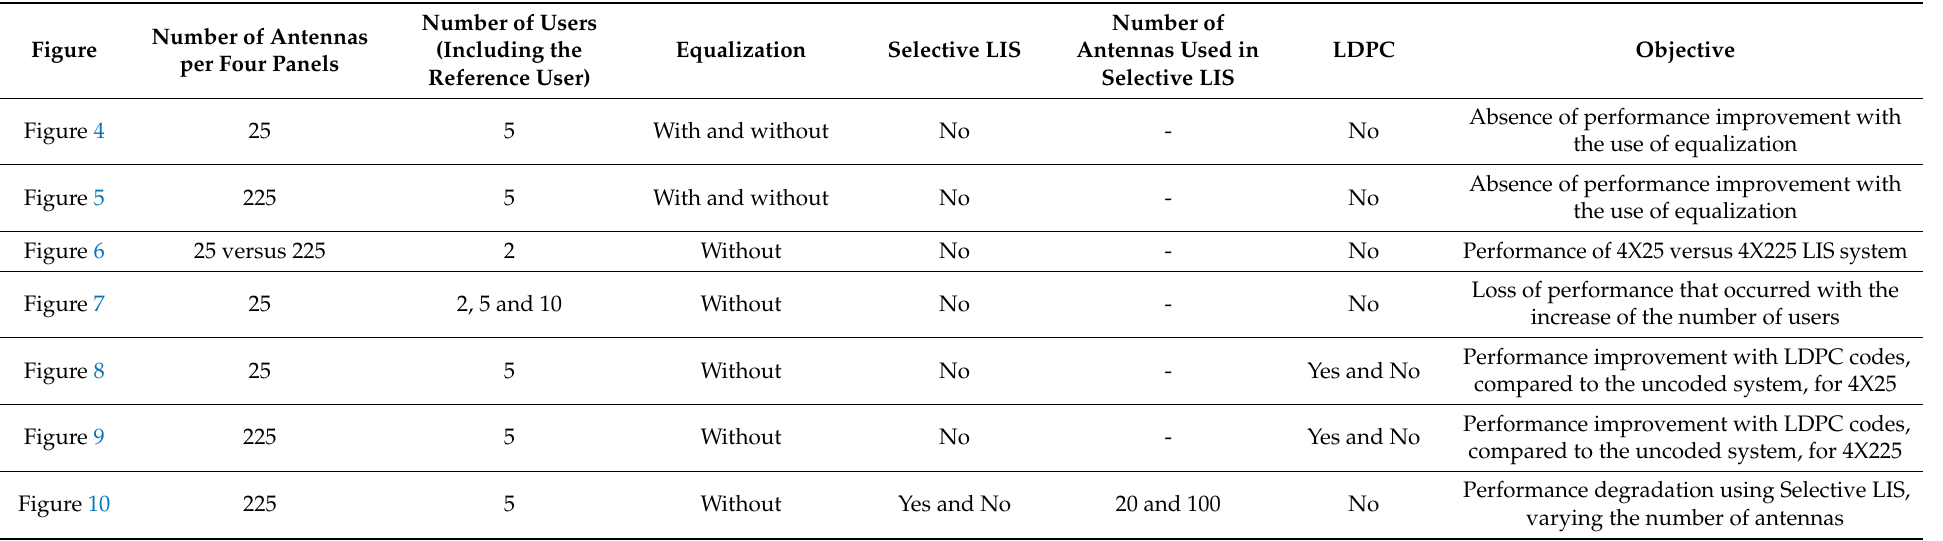
Table 2. The baselines used in Monte Carlo